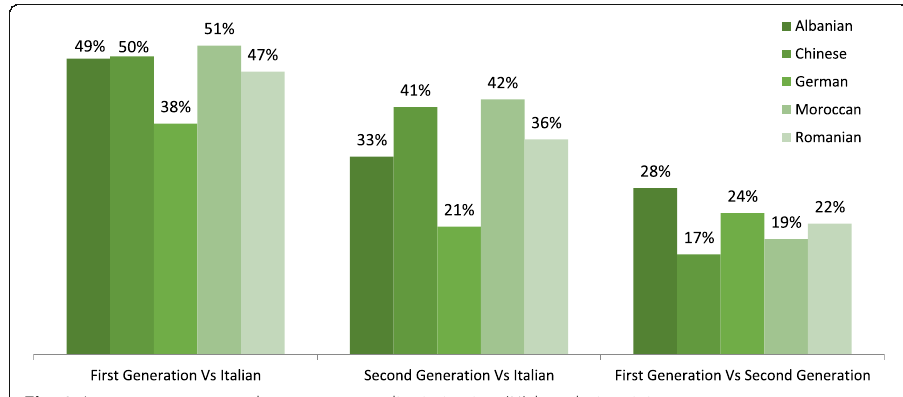
Fig. 2 Aggregate correspondence test — net discrimination (%) by ethnic